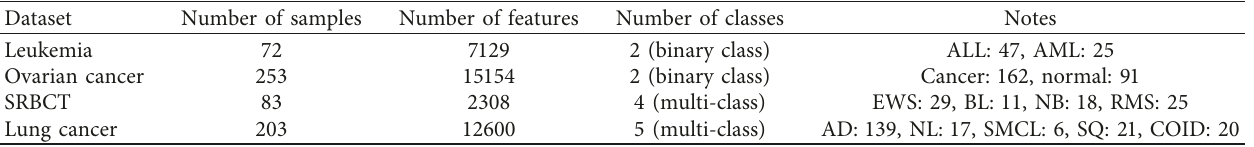
Table 1: Dataset description.